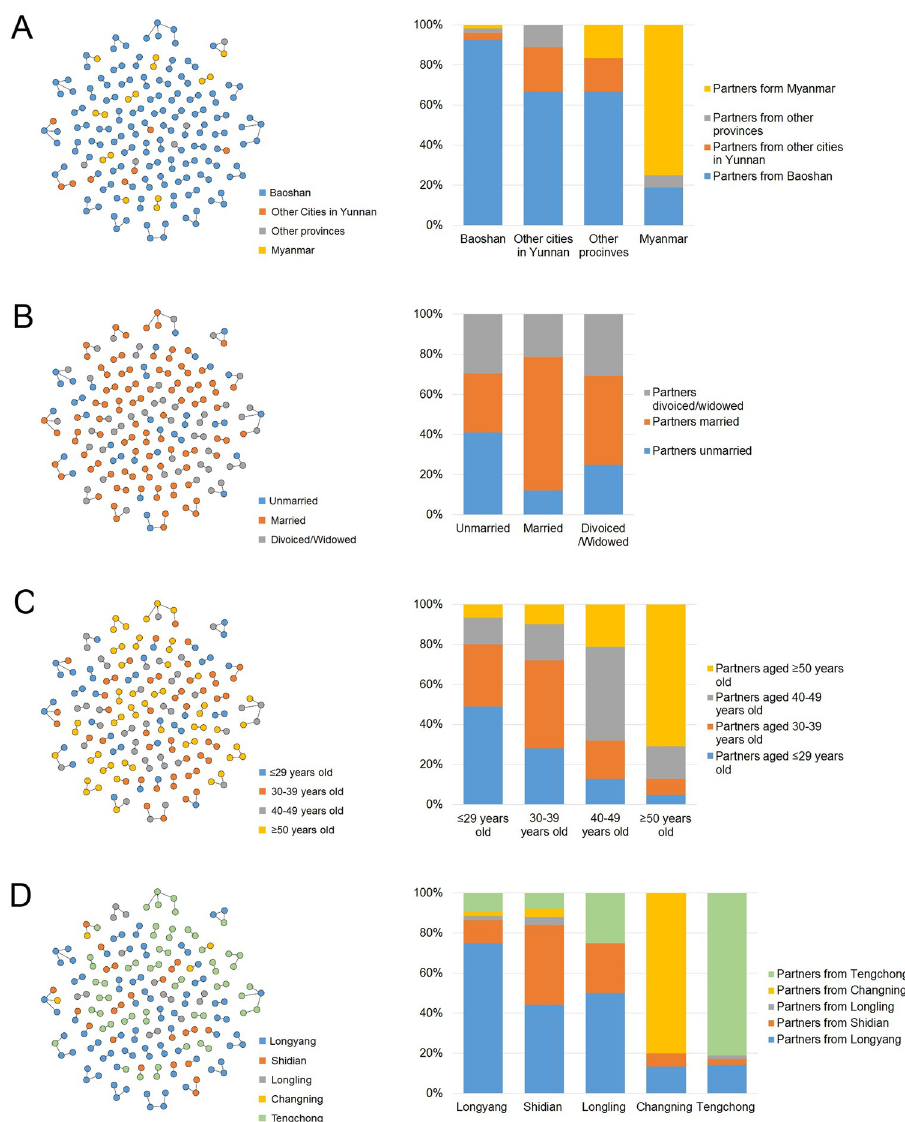
Fig 3. Relationship of the linked individuals in the HIV-1 molecular network in Baoshan Prefecture. A, Left panel: HIV-1 molecular clusters coded by regional category. Right panel: constitution of linked individuals stratified by regional category. B, Left panel: HIV-1 molecular clusters coded by marital status. Right panel: constitution of linked individuals stratified by marital status. C, Left panel: HIV-1 molecular clusters coded by age. Right panel: constitution of linked individuals stratified by age. D, Left panel: HIV-1 molecular clusters coded by counties where cases were reported. Right panel: constitution of linked individuals stratified by counties where cases were reported.